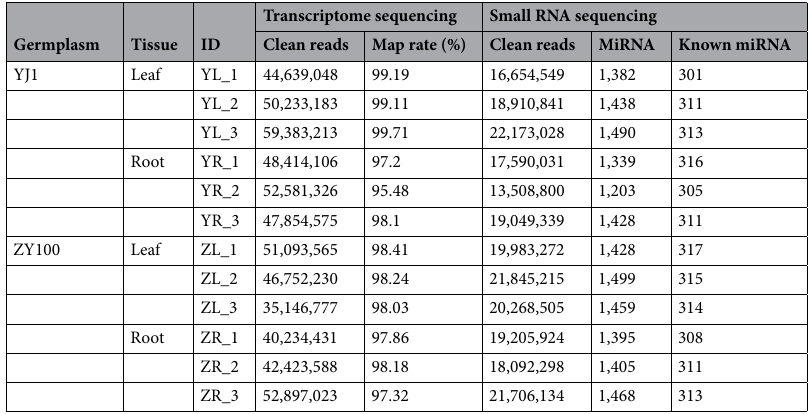
Table 1. Summary of transcriptome and small RNA sequencing data generated for 12 samples using Illumina sequencing platform.